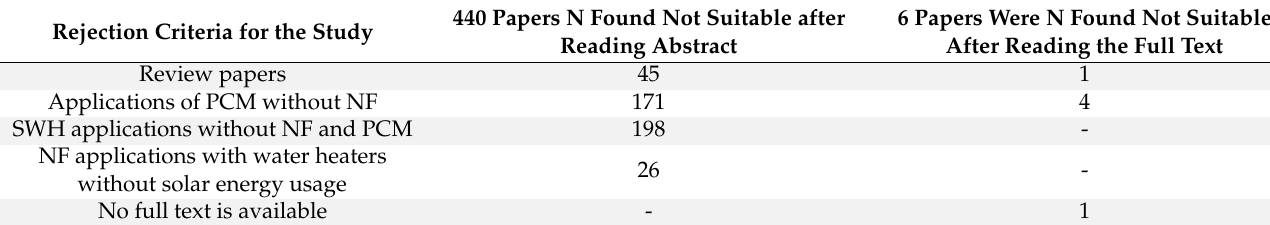
Table 1. Search terms and combinations